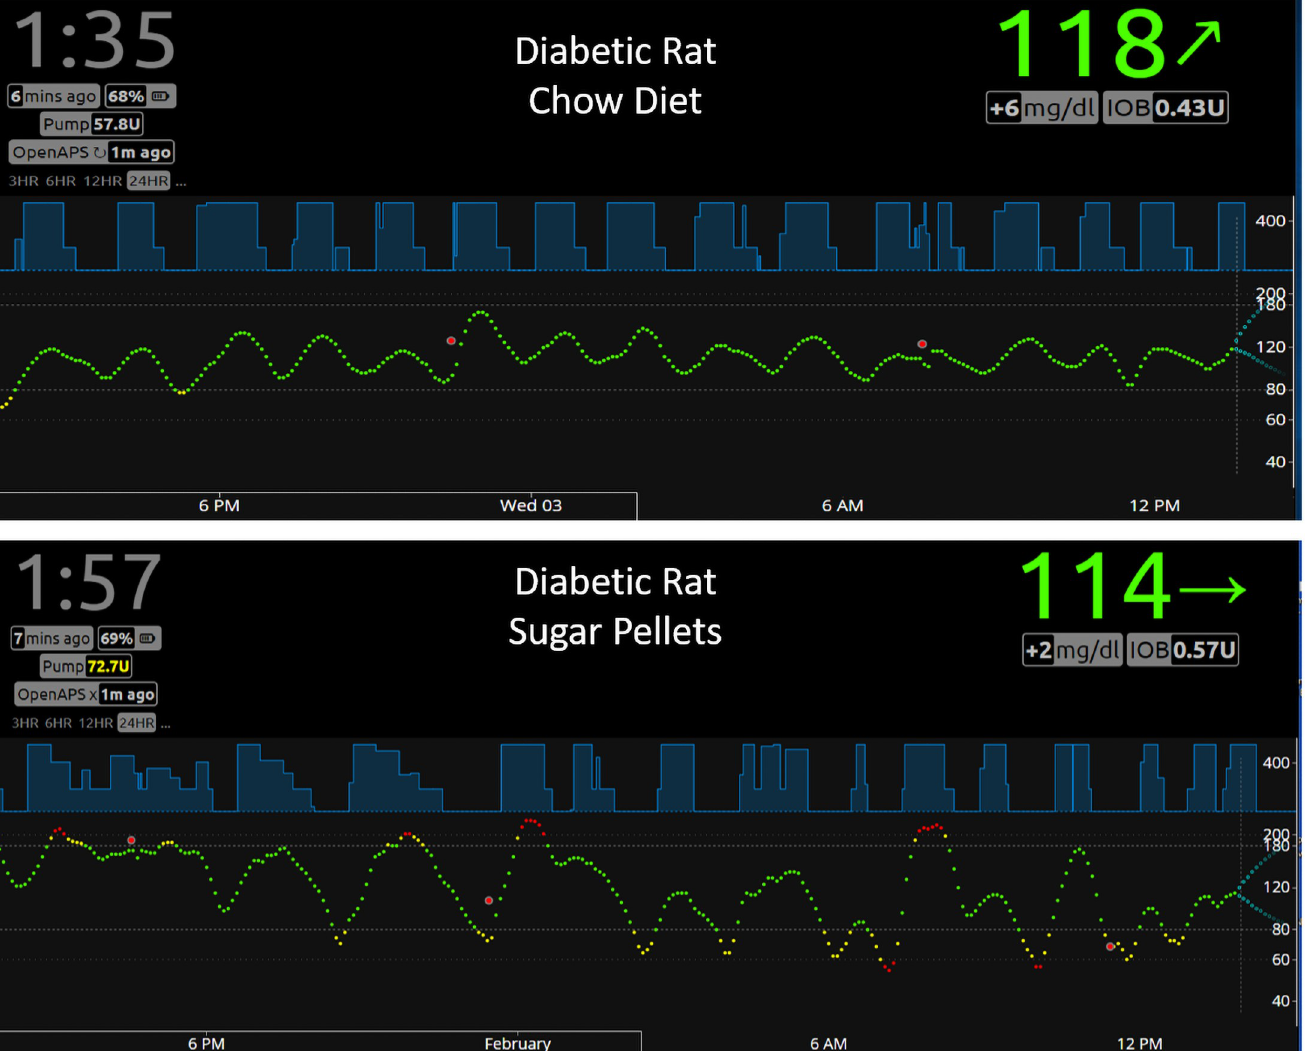
Fig 4. Effects of different diets on BGL and insulin infusion in diabetic rats. Representative Nightscout images of diabetic rats fed with chow diet (upper panel) or sugar pellets (lower panel) are shown. A total of 207 closed-loop hours (5 different rats with 10 independent experiments) using 1:7 dilution of Humalog was collected for diabetic rats fed with chow diet. Using the data analysis program described in the Methods section, the percent of time in hyper-, hypo- and normal glycemia as well as insulin infusion rate were calculated as shown in Table 1. A total of 175 closed-loop hours (3 different rats with 5 independent experiments) were collected for diabetic rats fed with sugar pellets (lower